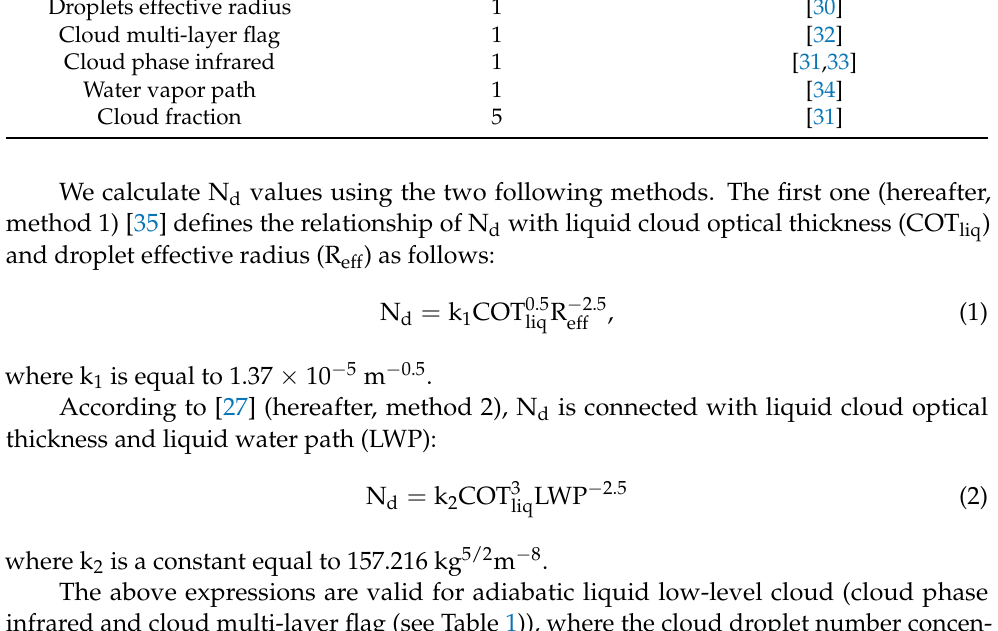
Data Resolution, km